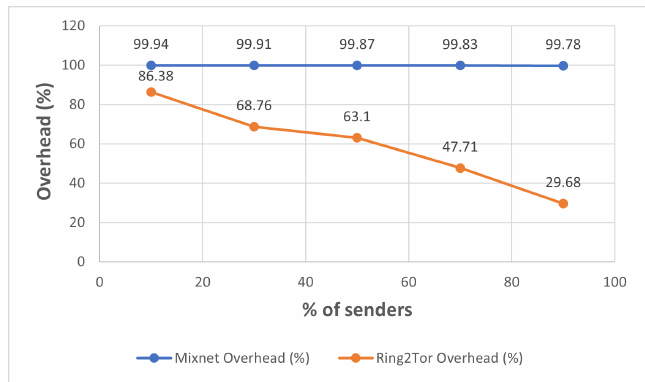
Figure 15. Overhead vs. percentage of senders in mixnet and